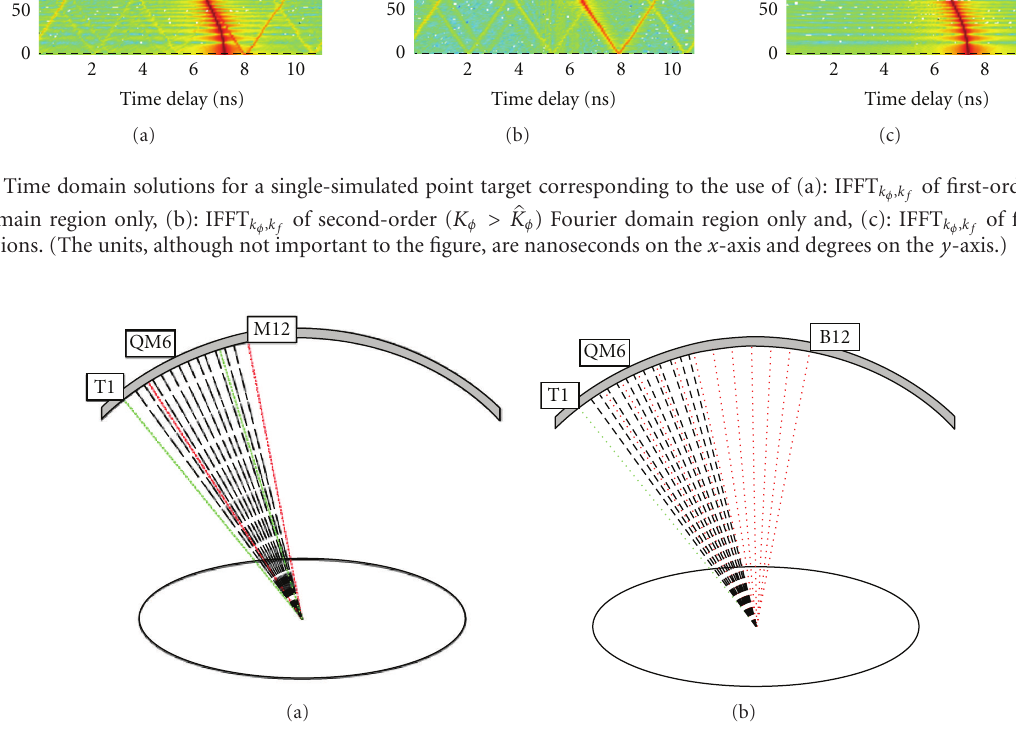
Figure 14: Equivalent QMS paths shown for (a) a pair of closely located antennas moving in sync across the arc and (b) a stationary transmitter and a moving bistatic receiver. Table 3: Description for point-target SWISAR